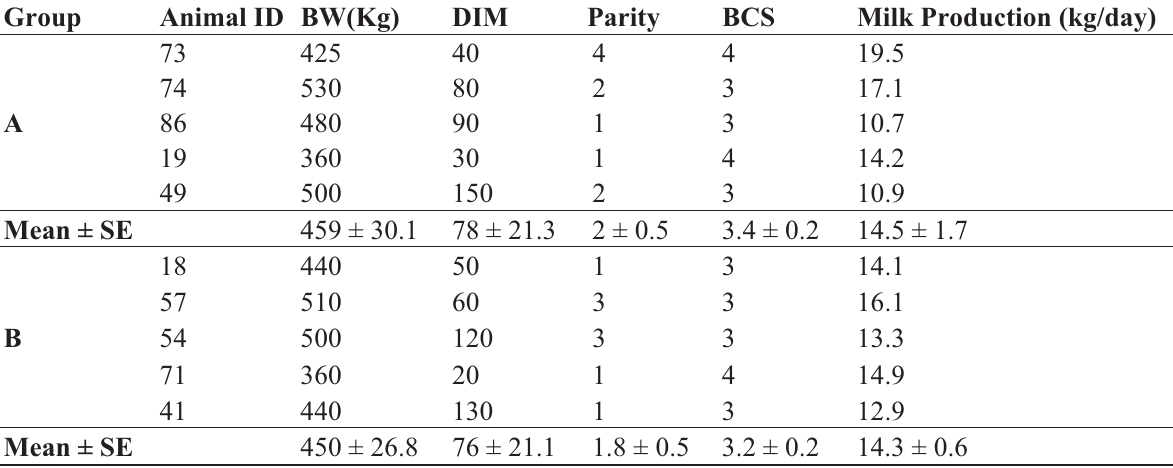
Table 1. Characteristics of the animals used in the experiment: group, animal identity (ID), production two days prior to the beginning of the experiment, mean and standard